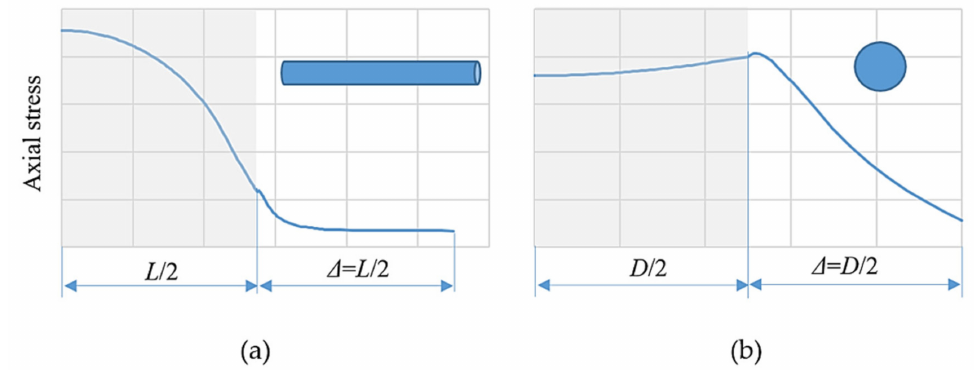
Figure 13. Axial stress in half of ( a ) fibre/( b ) particle: L /2 is half of fibre length, D /2 is half of particle diameter, ∆ is gap between